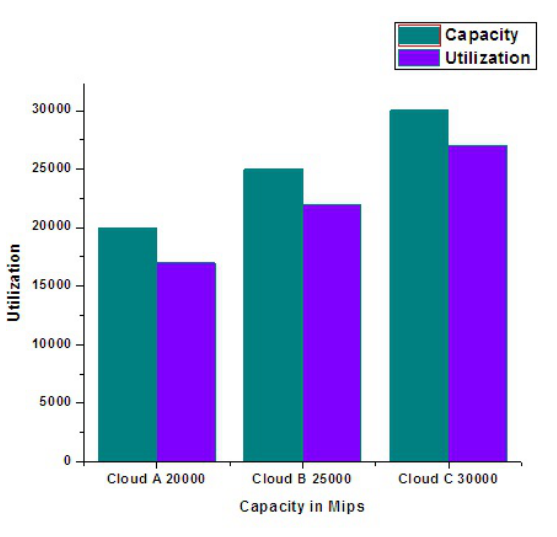
Figure 16. Use of cloud capacity. Figure 17 depict the average execution result of user application on local datacenter level.